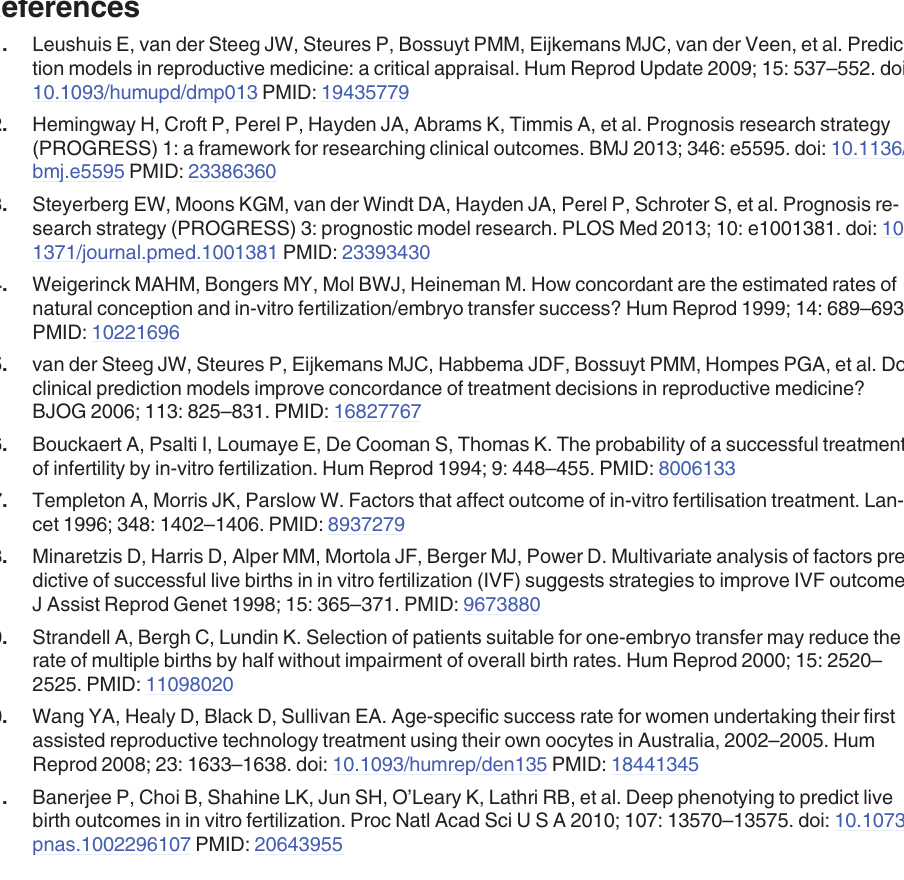
S2 Table. Figures for calibration plot for updated IVFpredict and Templeton models.